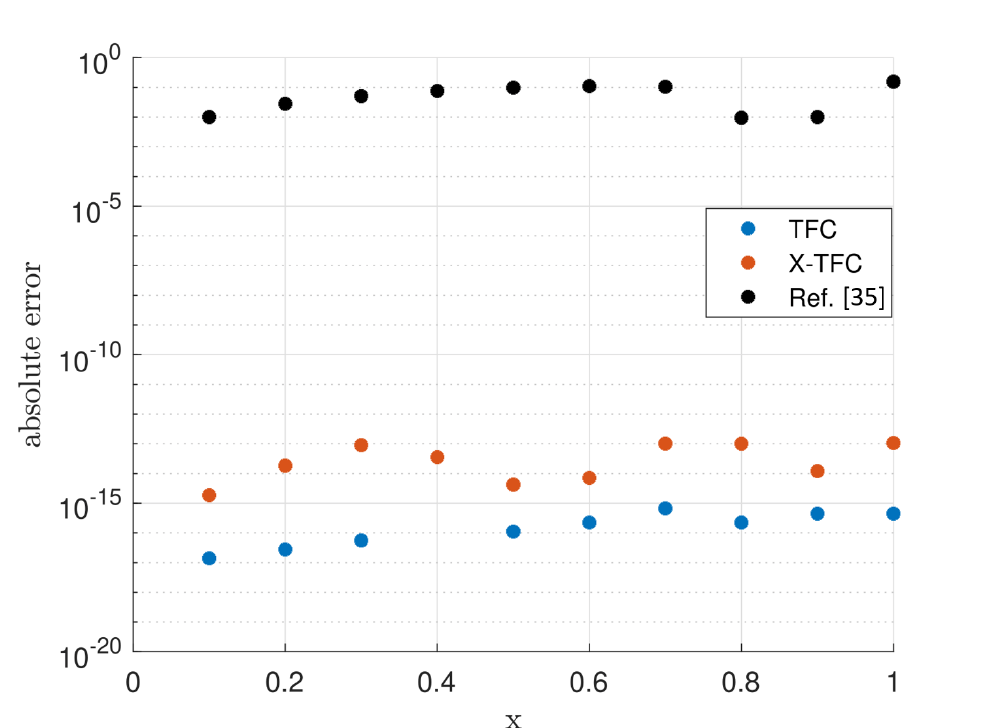
Figure 3. Absolute error on test points for problem